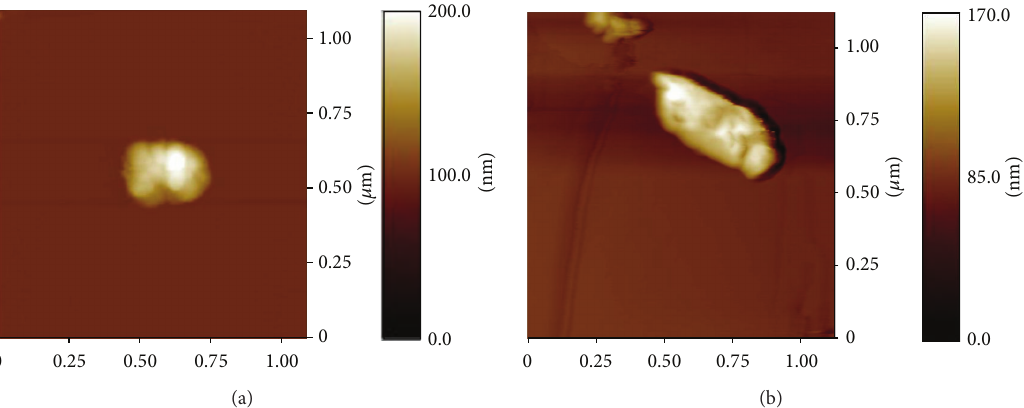
Figure 3: AFM topography images of 0.125 (a) and 0.875 (b) samples absorbed on a freshly cleaved mica disk and visualized in air operating in tapping mode.